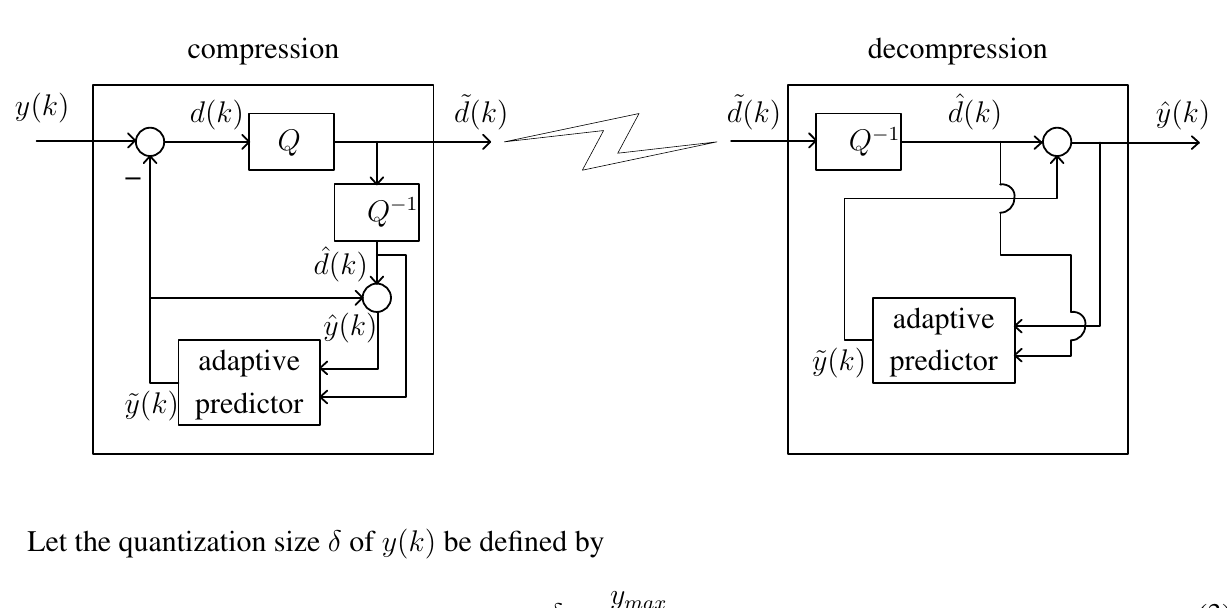
Figure 2. Encoder and decoder block